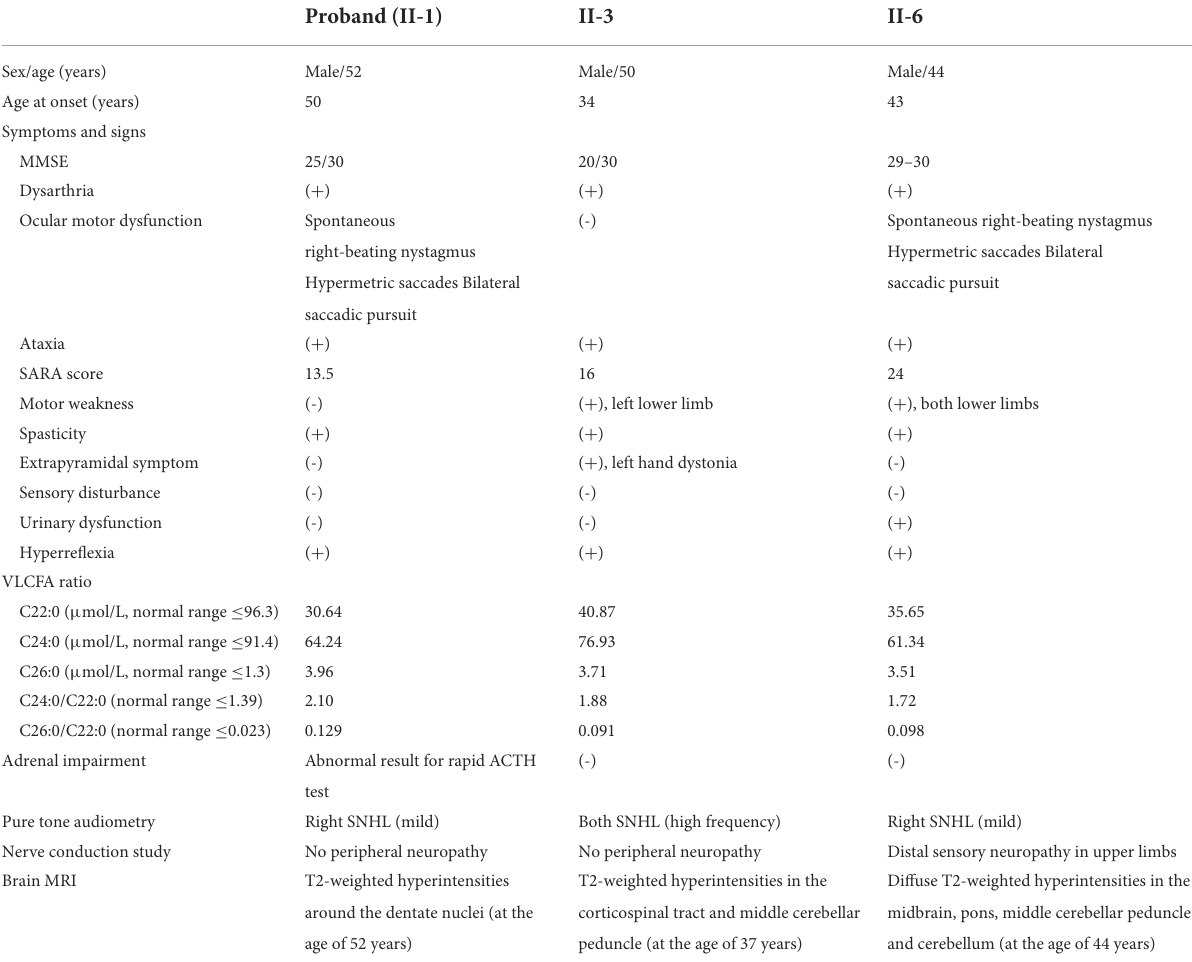
TABLE 1 Clinical characteristics of patients with X-linked